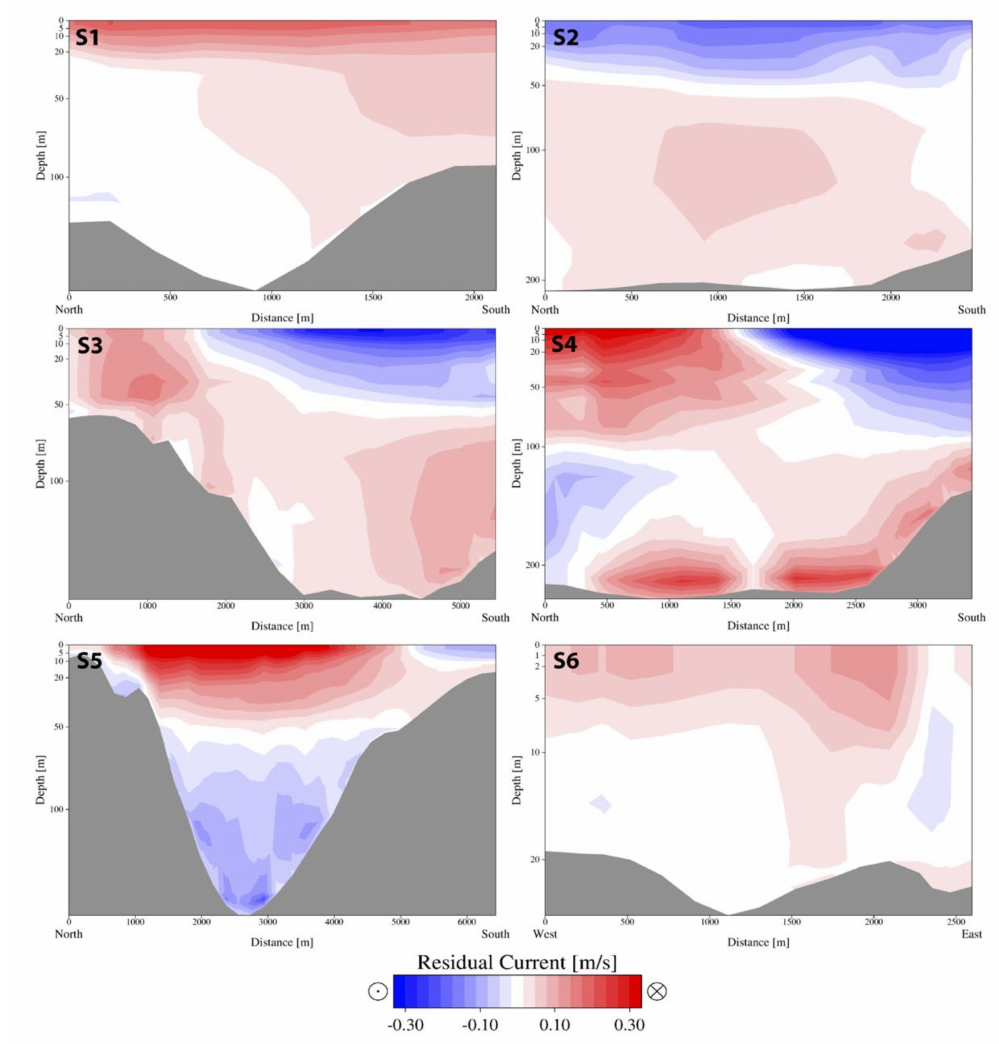
Figure A2. Yearly residual flow intensity through the sections S1–S6 along the BC as reported in Figure 2. Positive values indicate an eastward flow, except for section S6, where positive values indicate a southward